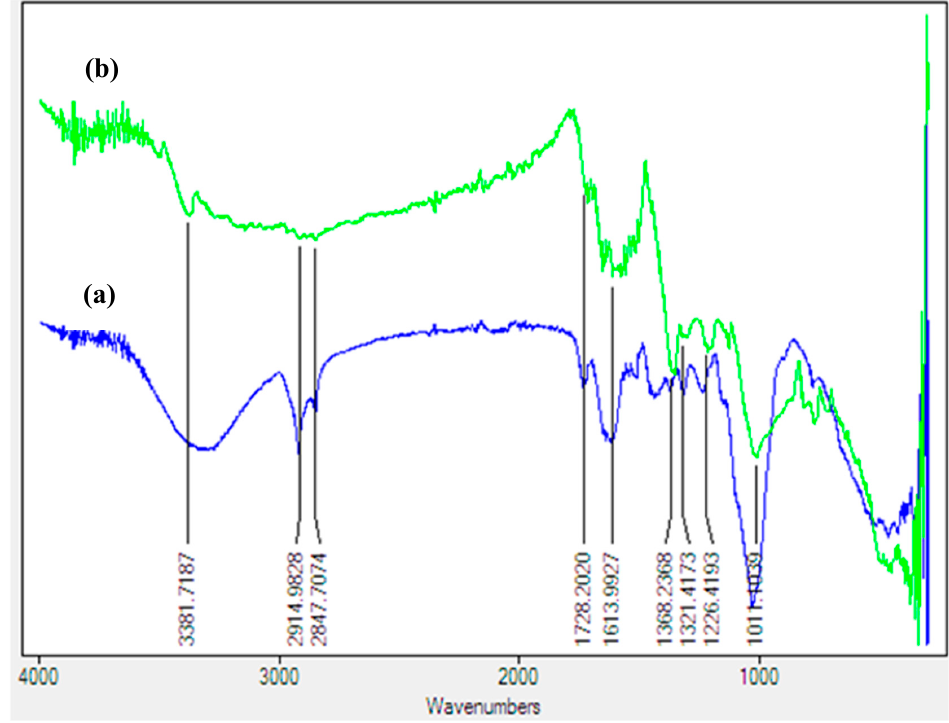
Figure 2. The FTIR spectra of the ( a ) Costus afer leaf and ( b ) biosynthesized AgNPs.